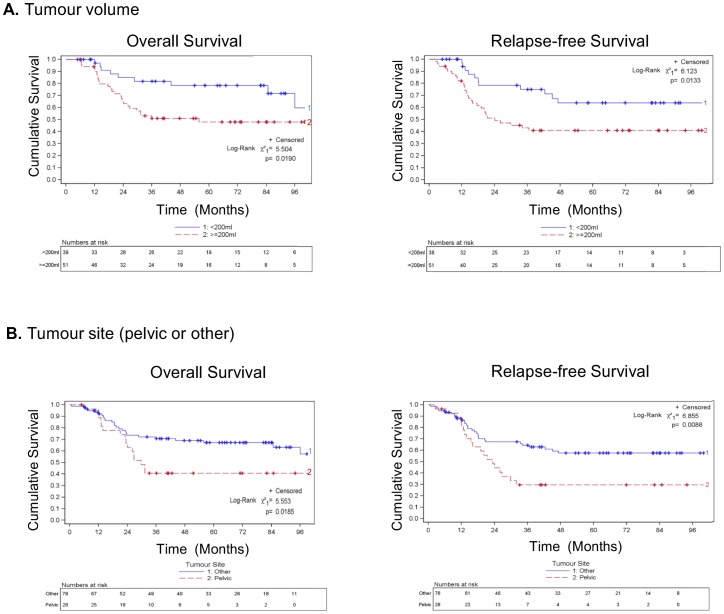
A. Kaplan Meier survival plots comparing the overall and relapse-free survival of patients with a tumour volume ≥200 ml with that of patients with a tumour volume <200 ml, p = 0.019 and 0.0133 respectively; log rank test. Crosses indicate censored events.B. Kaplan Meier survival plots to compare the overall and relapse-free survival of patients with pelvic tumours to that of patients with tumours at other sites, p = 0.0185 and 0.0088 respectively; log rank test. Crosses indicate censored events.